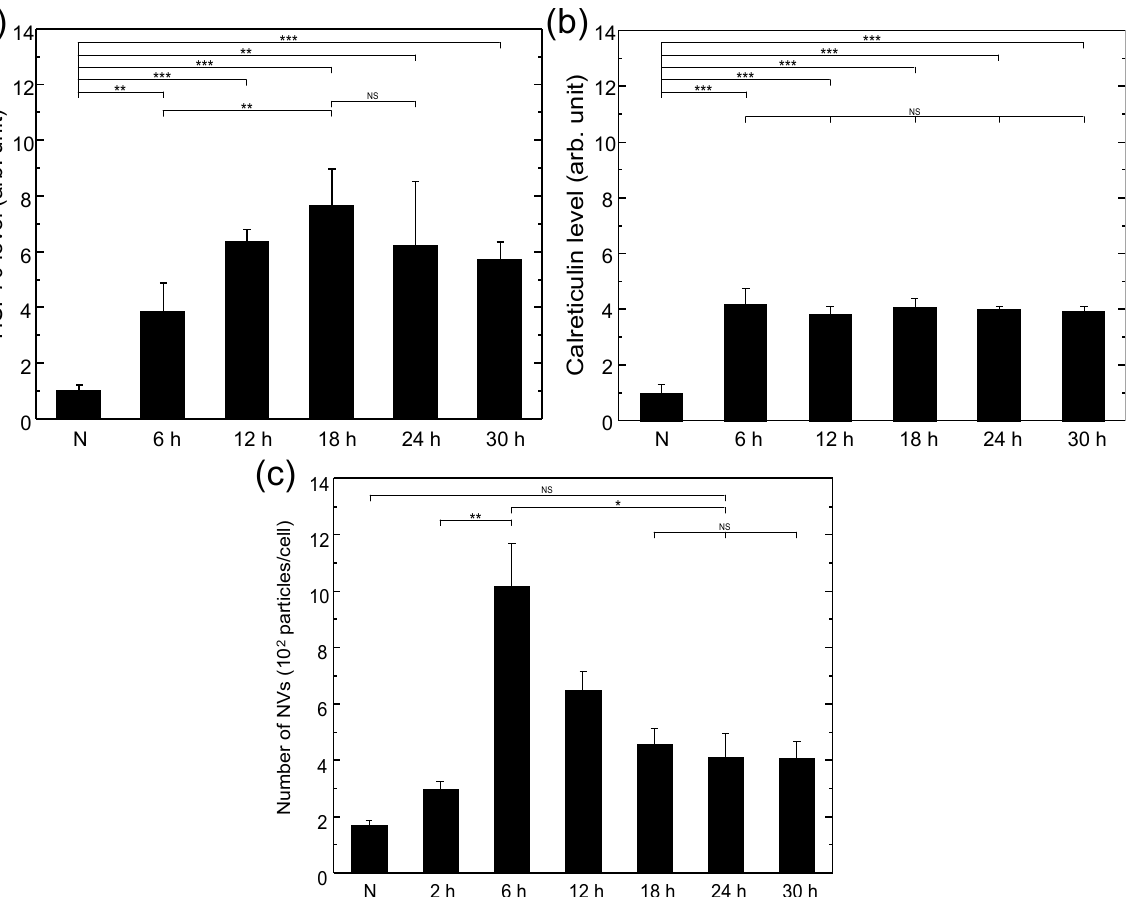
Figure 2. ( a ) Surface HSP70 expression of LLC cells as a function of recovery time after PDT treatment with 4 µ g/mL of verteporfin and 10 J/cm 2 fluence. The HSP70 level was normalized to that of the control group (N). N: without PDT treatment. ( b ) Surface calreticulin expression of LLC cells as a function of recovery time after PDT treatment with 4 µ g/mL of verteporfin and 20 J/cm 2 fluence. The calreticulin level was normalized to that of the control group (N). N: without PDT treatment. ( c ) The number of spontaneously released nanovesicles as a function of time after PDT treatment. N: number of nanovesicles spontaneously released from LLC cells in a time span of 24 h without PDT treatment. Data are expressed by mean ± SD (( a ) N = 4, ( b ) N = 4, ( c ) N = 3), NS: no significant difference, *: p -value < 0.05, **: p -value < 0.01, and ***: p -value <